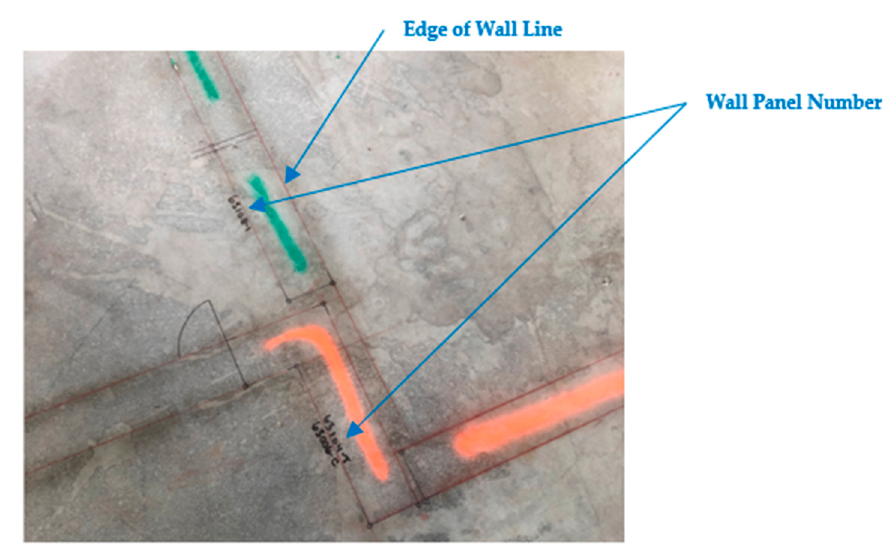
Figure 9. Example advanced wall layout for panel installation.